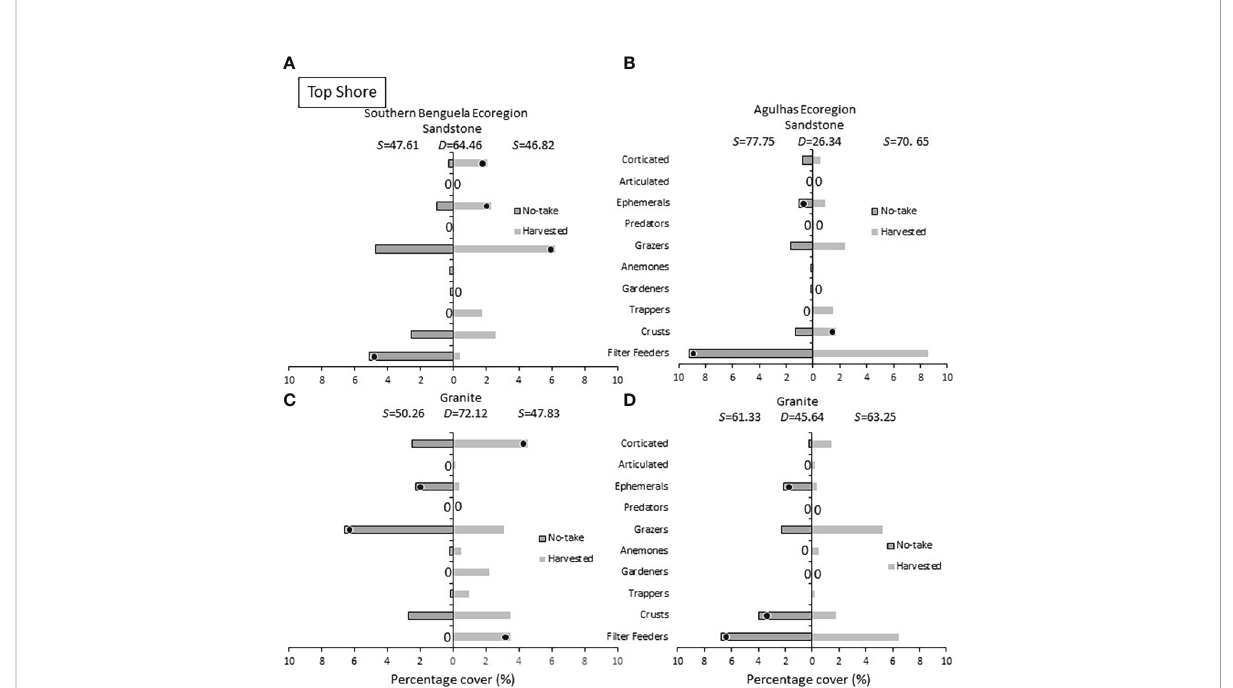
FIGURE 9 Top shore: Percentage cover of groups responsible for similarities ( S ) within harvested or no-take areas and dissimilarities ( D ) between them, on (A) sandstone in the Southern Benguela and (B) Agulhas ecoregions, and on granite in (C) the southern Benguela and (D) Agulhas. See caption for Figure 6 for further interpretation.